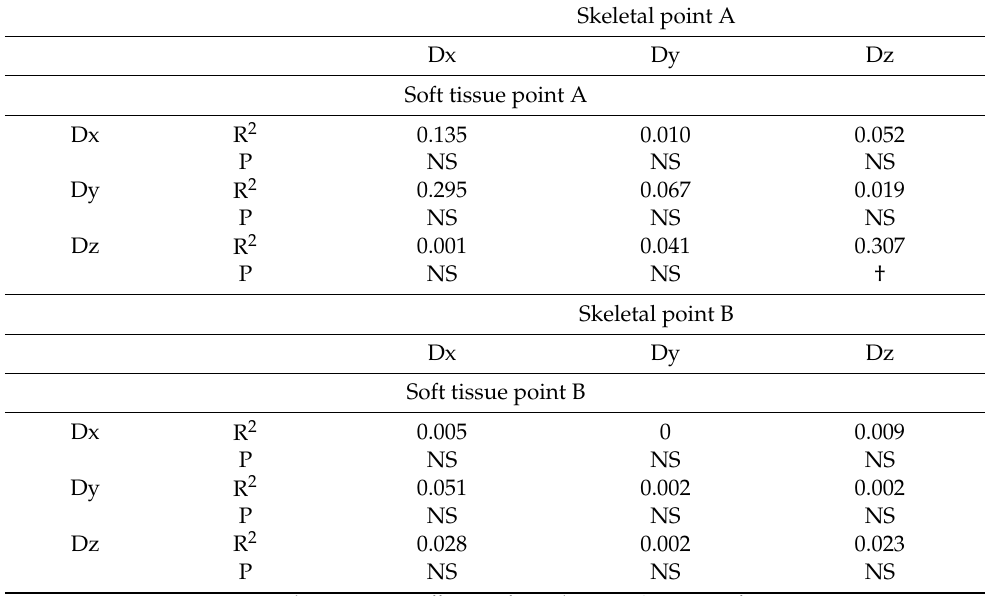
Table 4. The coefficient of correlation and p -values between skeletal and soft tissue points A and B